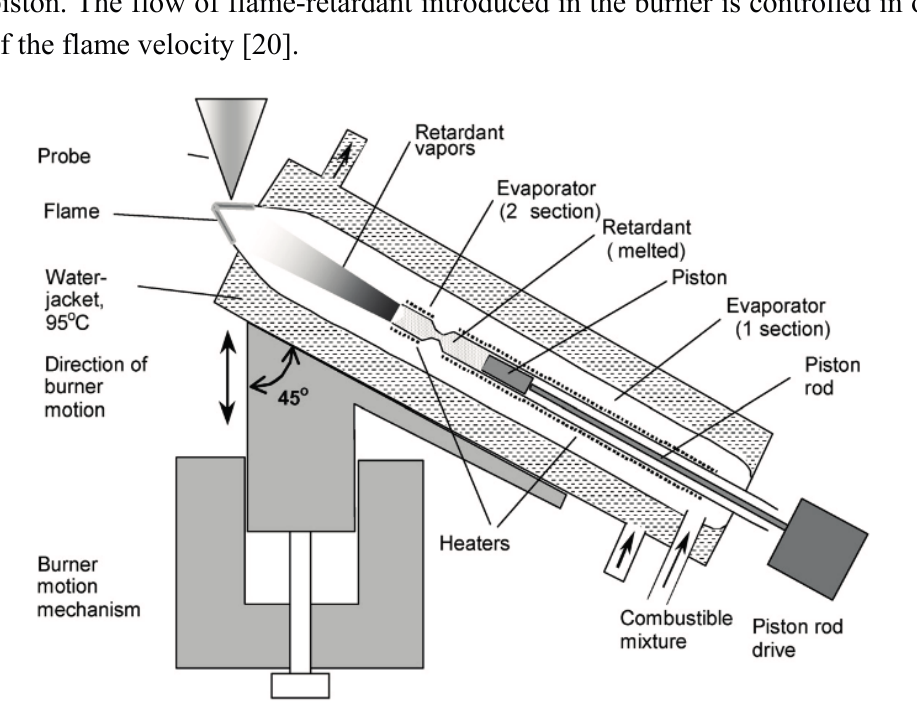
Figure 2. Description of an experimental burner setup. (Reprinted from ref.